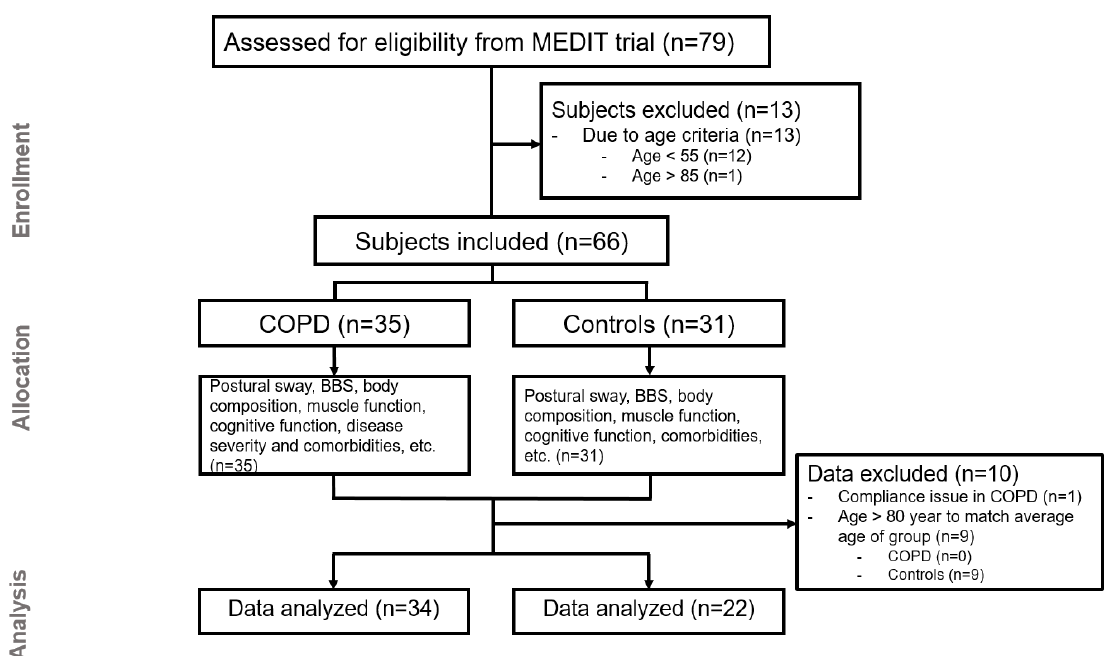
Figure 1. Consort flow diagram of the study.